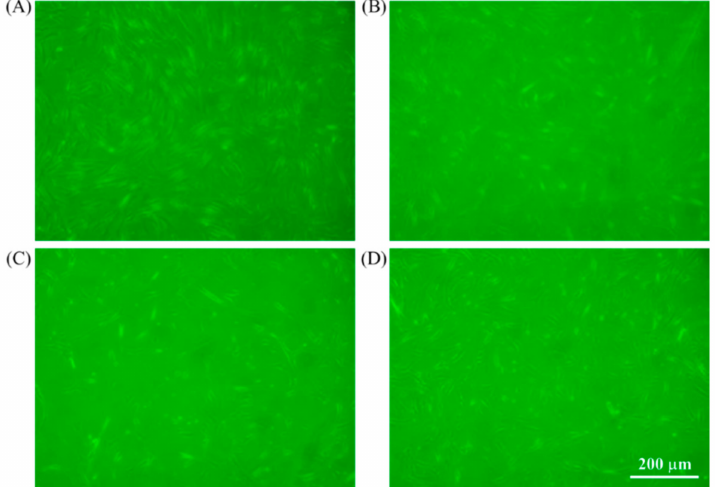
Figure 2. Microscopic findings (10 × ) demonstrated the proliferation of human fibroblast cells for